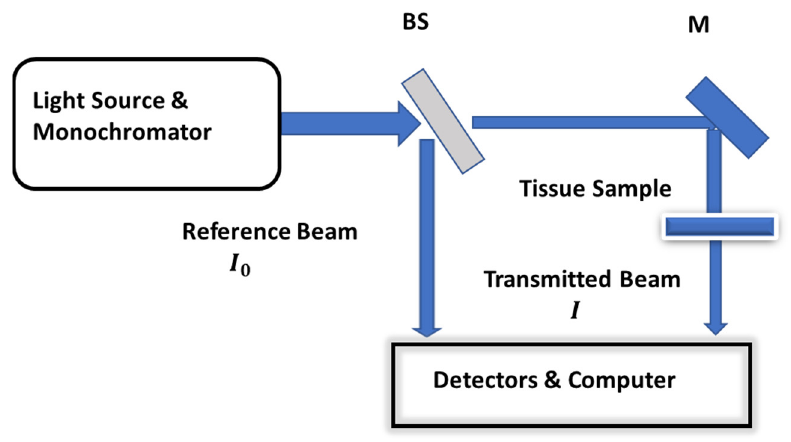
Figure 2. Double-beam spectrophotometer: BS (beam splitter) and M (mirror).